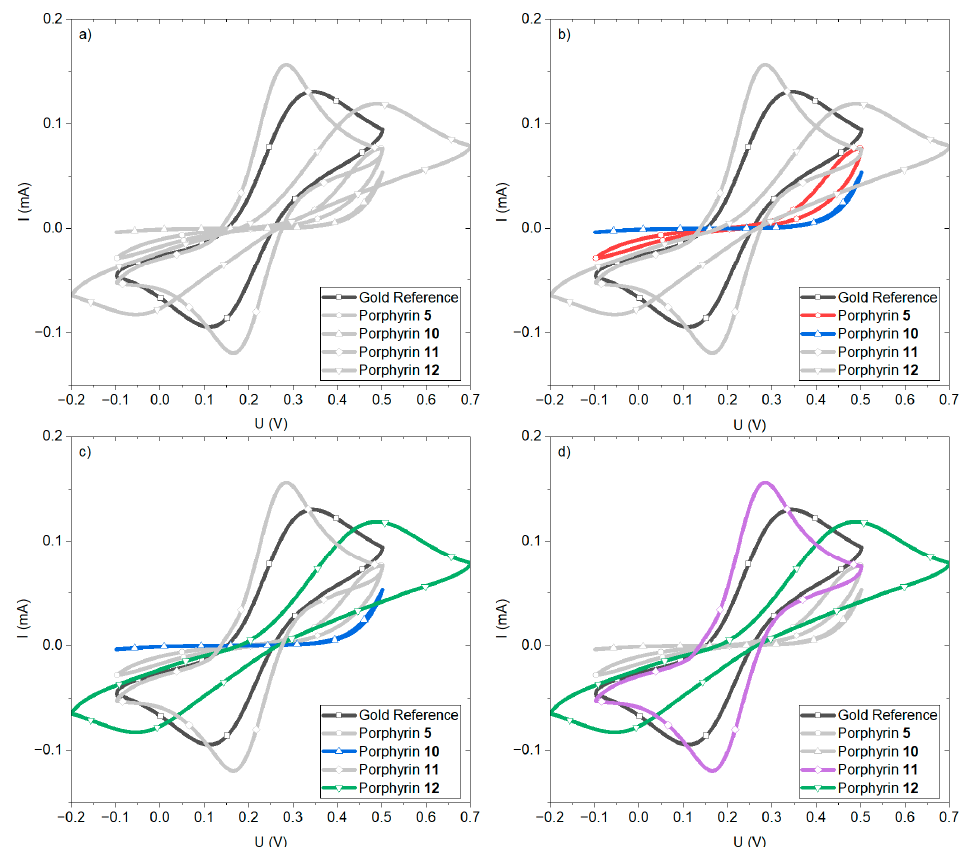
Figure 2. Cyclic voltammograms of the porphyrin-SAM functionalized gold substrates as the working electrode compared to the gold reference without porphyrin-SAM. Measured in a 1 mmol/L K 4 [Fe(CN) 6 ] and a 0.1 mmol/L KCl aqueous solution. Graphs are grey when not relevant for the detailed discussion.